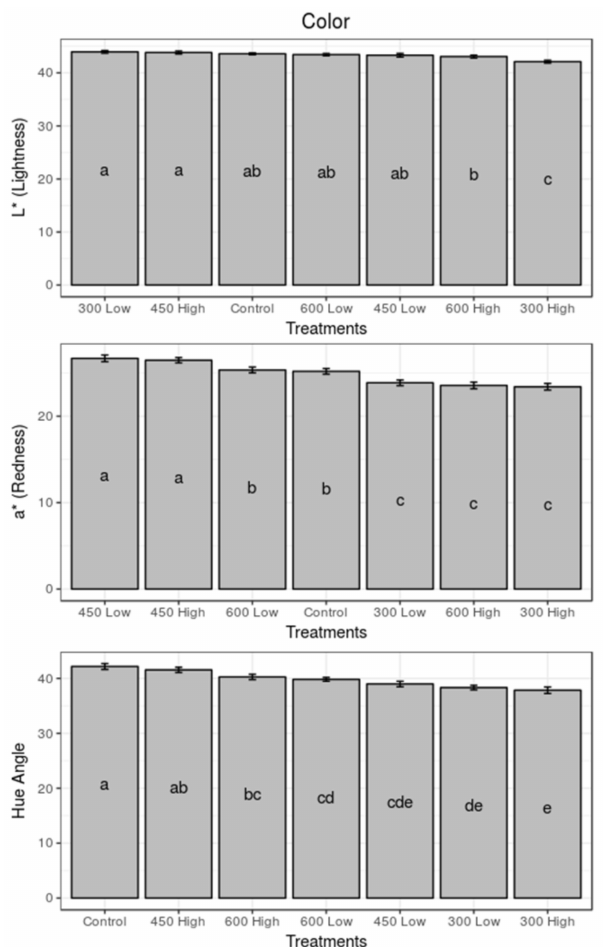
Figure 2. Color coordinates, a*, L*, and hue angle values, of tomatoes cultivated in the standard (control) and biochar amended media. Bars represent standard error ( n ≈ 30). Different letters show significant difference ( p < 0.05) between